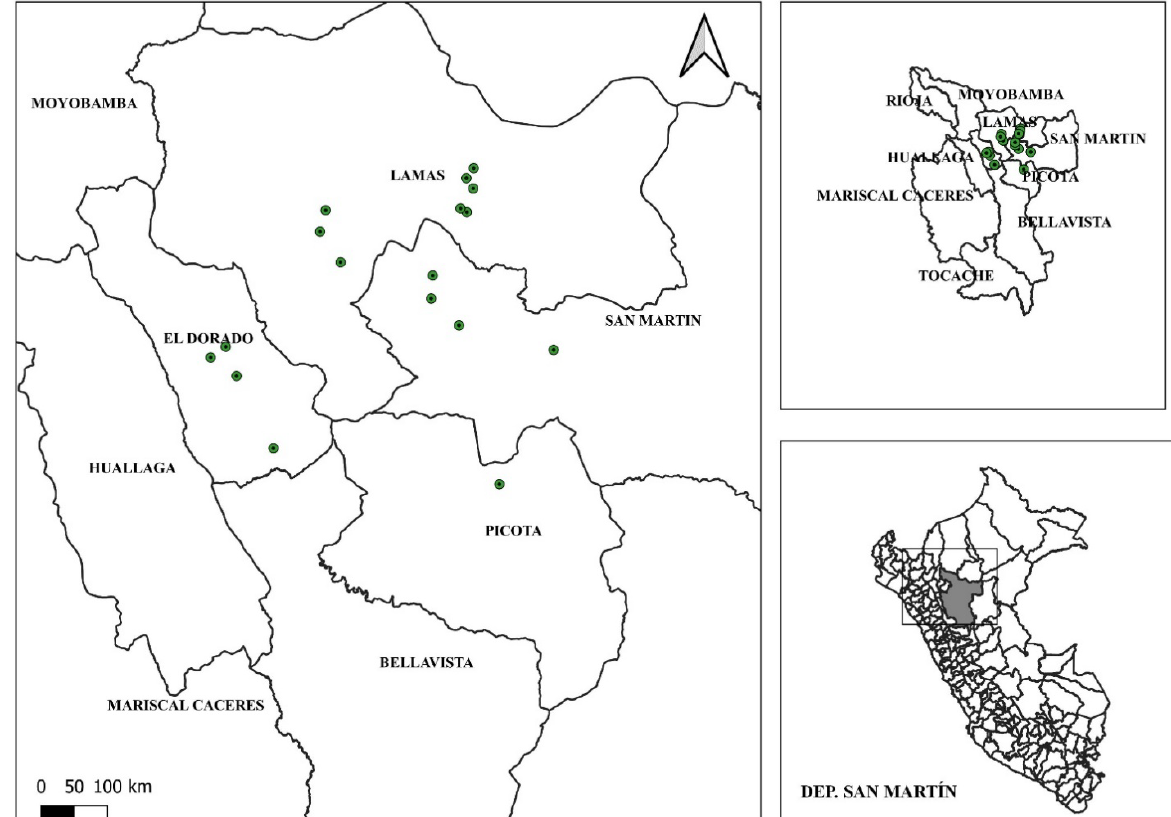
Figure 1. Study location, distribution in the Provinces of San Martin